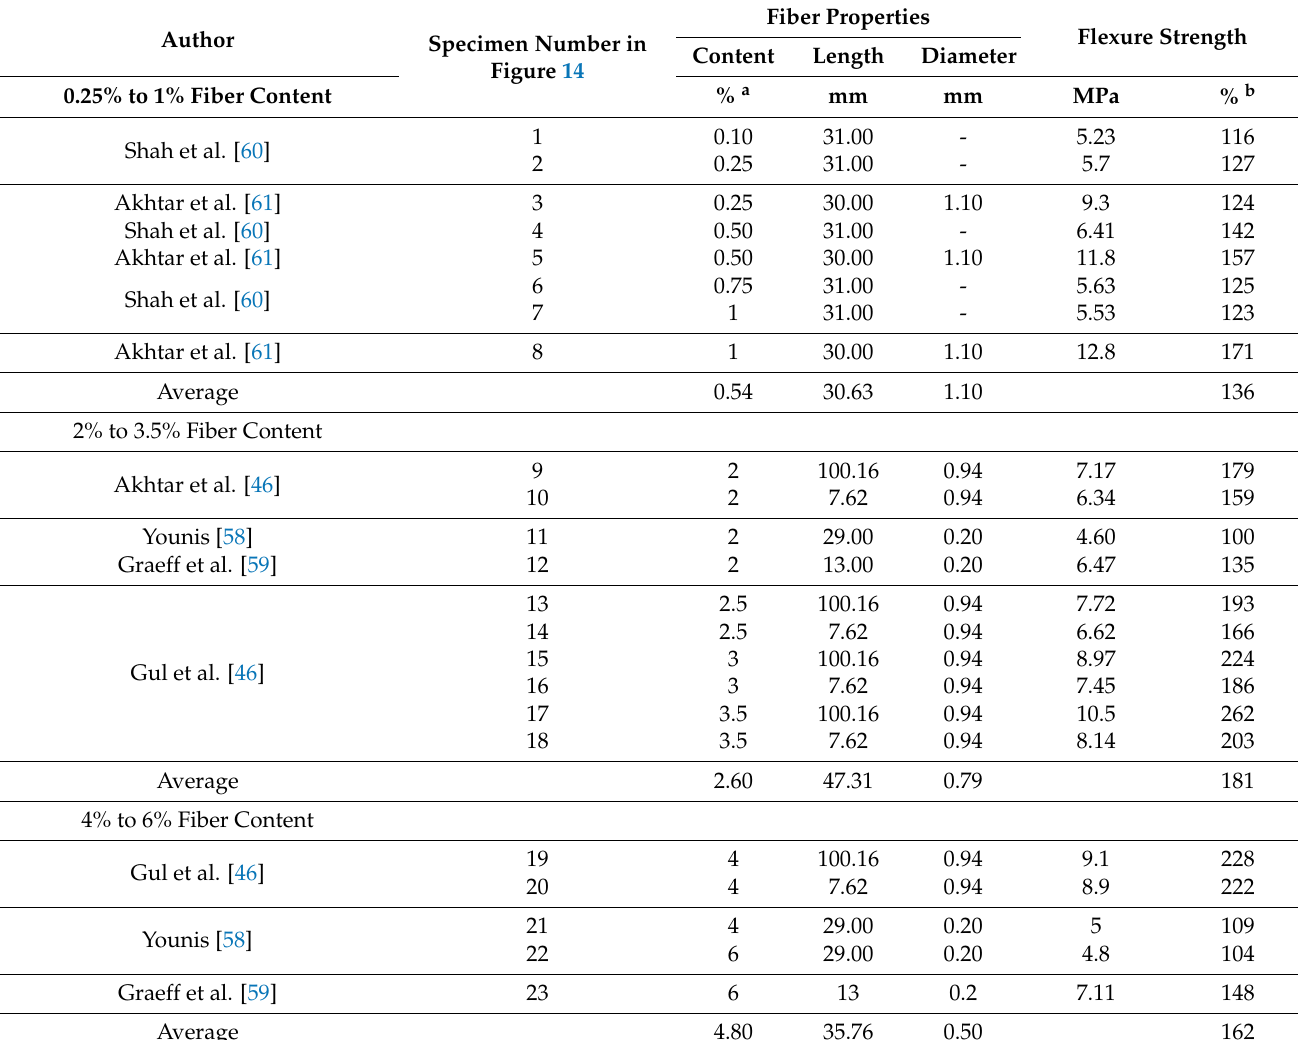
Table 10. Results of flexure strength’s percent comparison and fiber properties of the concrete incorporating RSF by weight